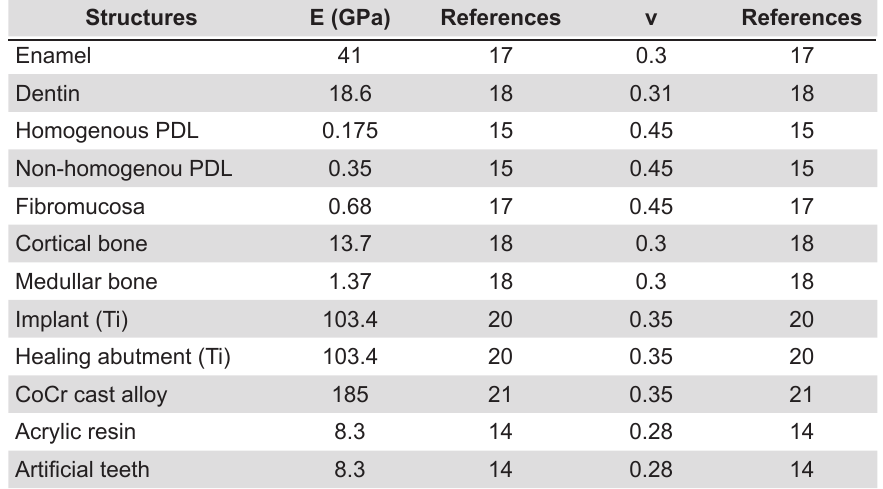
Figure 1- Description of finite element models, finite element mesh and boundary condition. A: Models A, B, and C. B - Model B with the removable partial denture (RPD). C: Model C with RPD and implant. Areas (1 to 6) selected to perform the analysis in all models. D:- The beam elements used to build the non-homogeneous periodontal ligament (PDL). E and F: Mesh refinements for tooth apex and implant, respectively. L shows the distributed loading scheme. The entire right and left sides were fixed on the x axis. The bone at the bottom of the model was fixed on the x and y Table 1- Mechanical properties of the materials. E – Elastic modulus. v – Poisson’s ratio. PDL – Periodontal ligament. Ti - Titanium